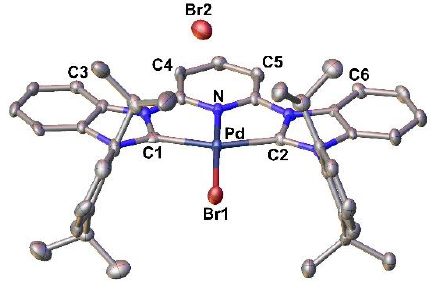
Figure 2. Solid-state structure of 3 benz . Ellipsoids are shown at the 50% probability level. Hydrogen atoms are omitted for clarity. Selected bond lengths [Å ] and angles [°]: C1–Pd 2.012(7), C2–Pd 2.027(7), N(pyridine)–Pd 1.977(6), Br1–Pd 2.393(1), C3–C4 3.352, C5–C6 3.329; C1–Pd–N(pyridine) 79.5(3).